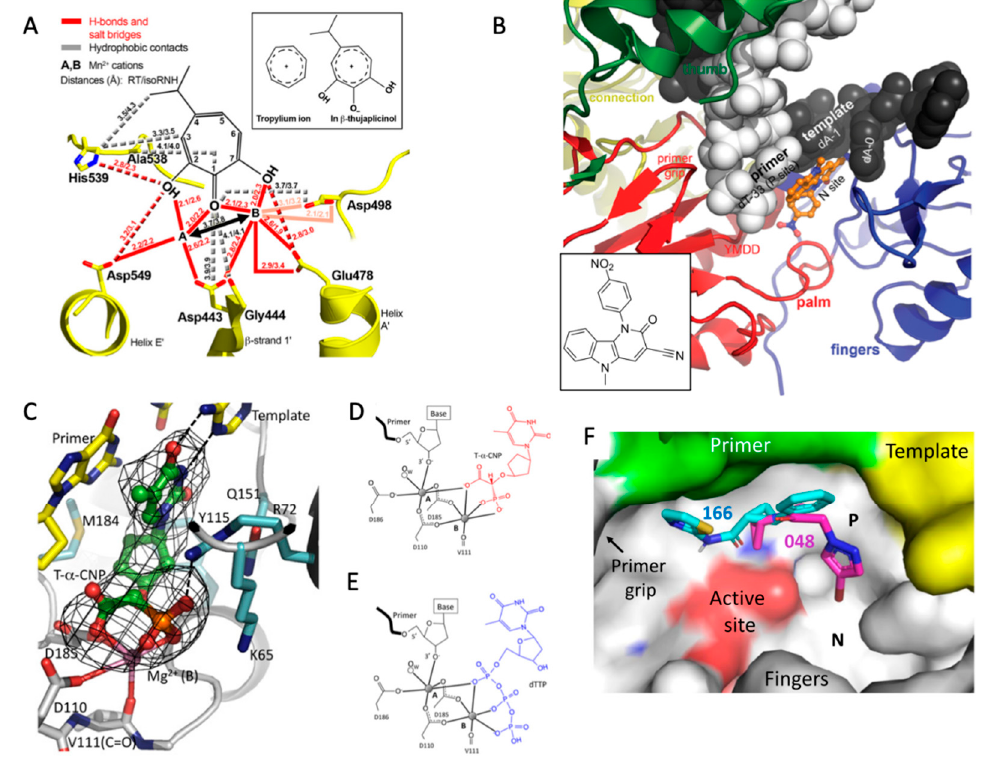
Figure 6. Other key potential target sites of HIV-1 RT. ( A ) Binding of β -thujaplicinol at the RNase H active site via chelation to Mg 2+ ions A and B; reprinted with permission from Reference [121]; copyright (2009) Elsevier Ltd. ( B ) Binding of the NcRTI, INDOPY-1 at the polymerase active site (PDB ID = 6O9E); the figure is reprinted with permission from Reference [126]; copyright (2019) American Chemical Society ( C ) Binding of α -CNP at the polymerase active site of HIV-1 RT (PDB ID = 4R5P), and the polymerase active site metal chelation of α -CNP ( D ) and dTTP ( E ); the figures ( C – E ) are reprinted from Reference [127]; copyright (2015) National Academy of Sciences. ( F ) Binding of two drug-like fragments 166 and 048 to the transient P-pocket (PDB IDs: 7OZ5 and 7OXQ, respectively).